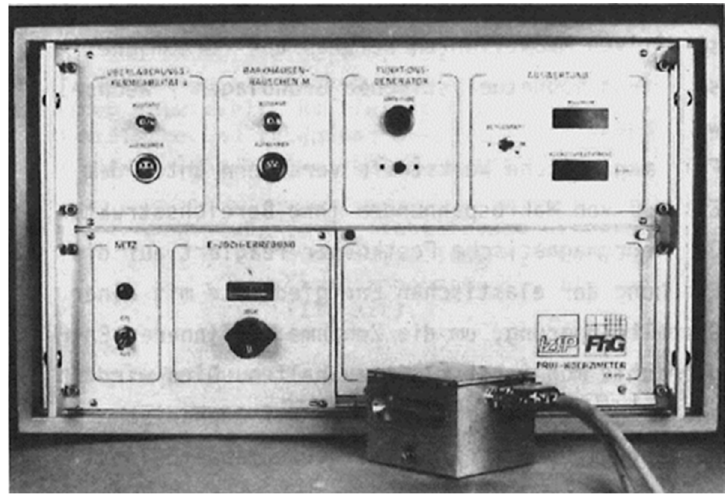
Figure 1. First micromagnetic testing device EM8101 of Fraunhofer IZFP.